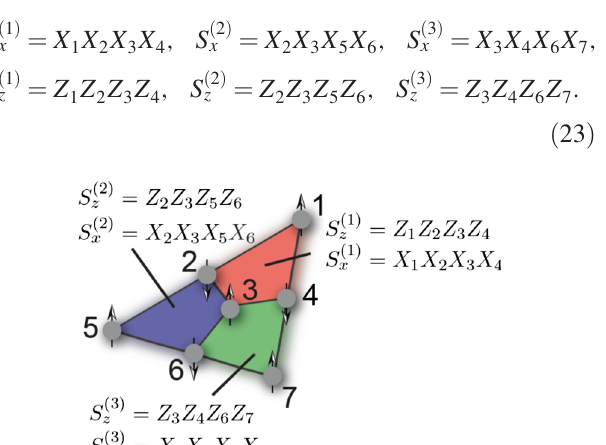
FIG. 3. Scheme of the seven-qubit color code: One logical qubit is embedded in seven data qubits forming a 2D triangular color- code structure of three plaquettes. The code space is defined via S x and S z stabilizer operators (generators), each acting on a plaquette i that involves four physical qubits. Logical operators such as Z L ¼